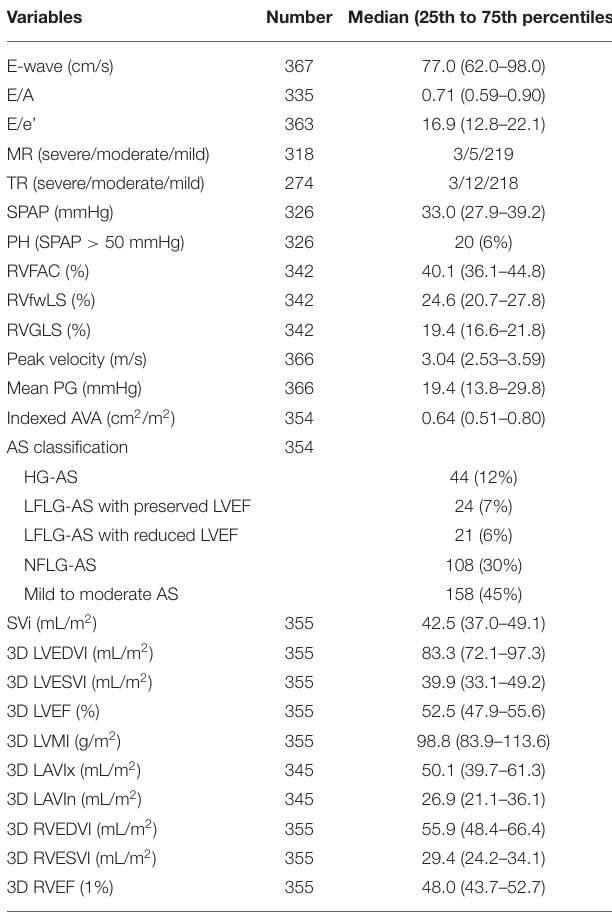
TABLE 2 | Echocardiographic parameters ( n =